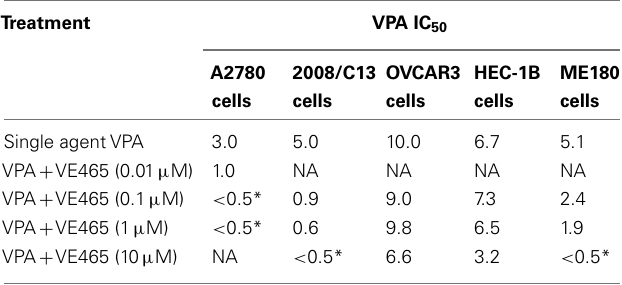
Table 2 | Decreased IC 50 ofVPA (mM) in combined treatment with VE465 in gynecologic cancer